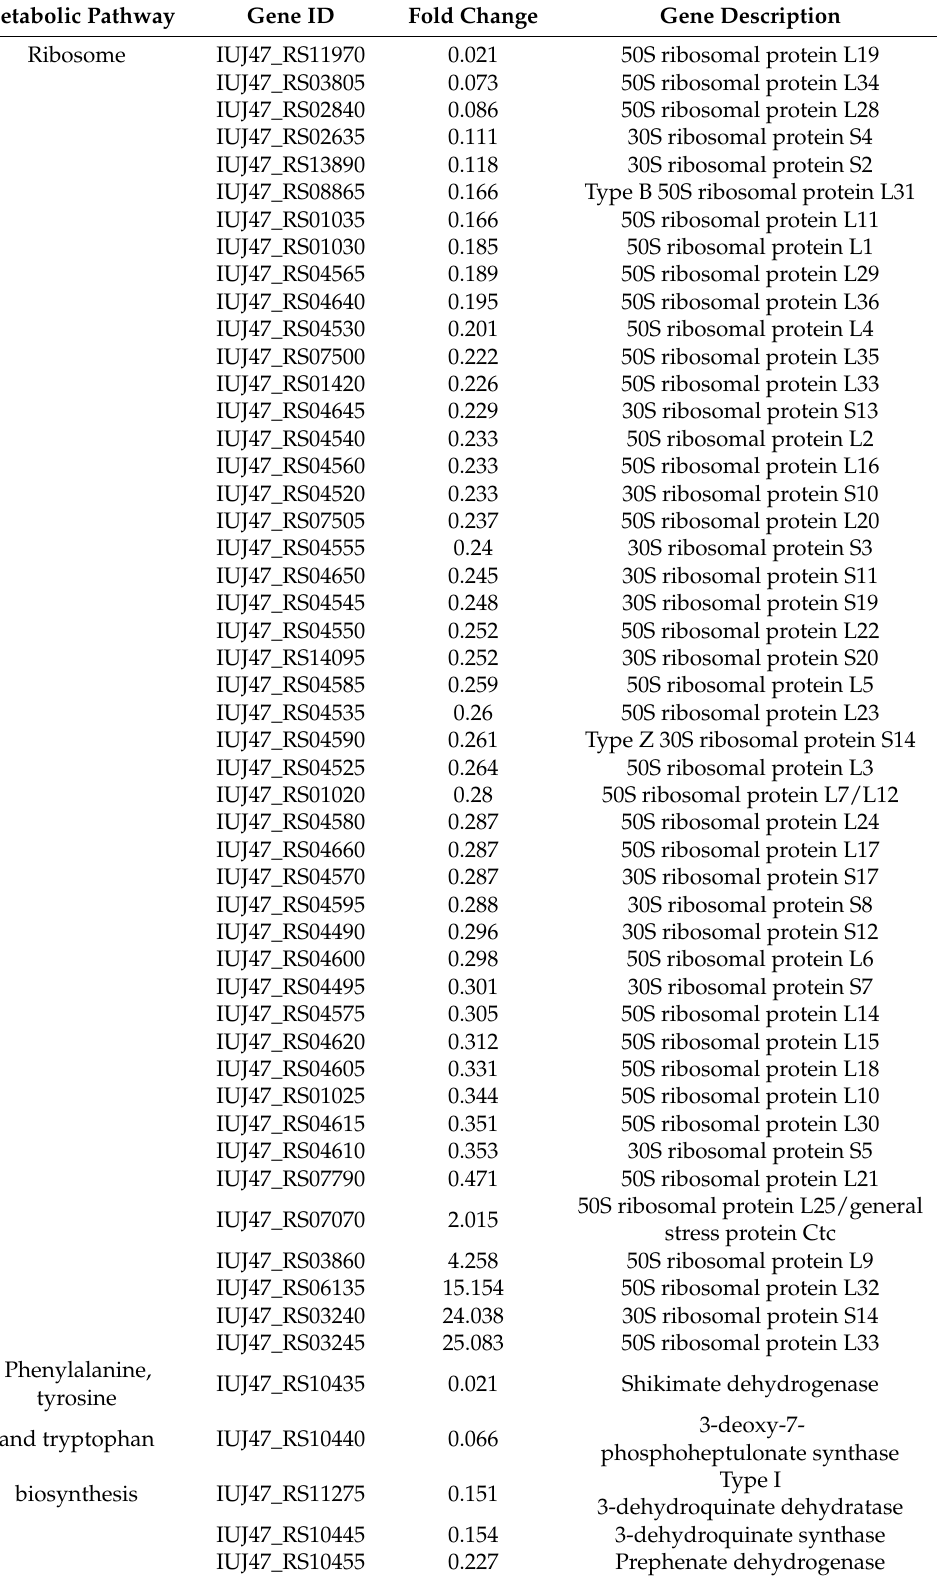
Table 7. Major altered metabolic pathways in E. faecalis C1-1 mediated by Fragment 1 from C. communis